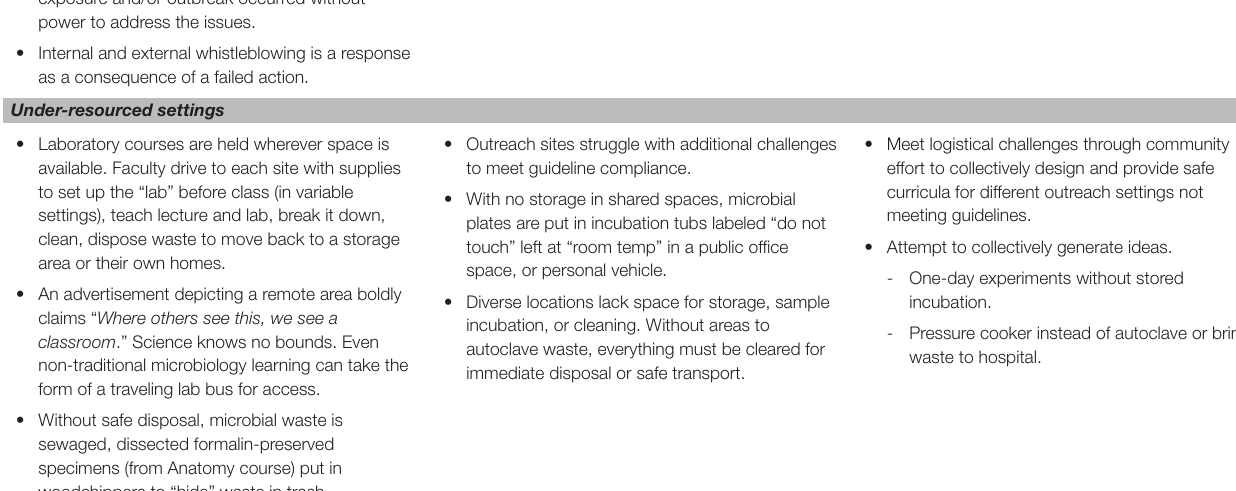
Under-resourced